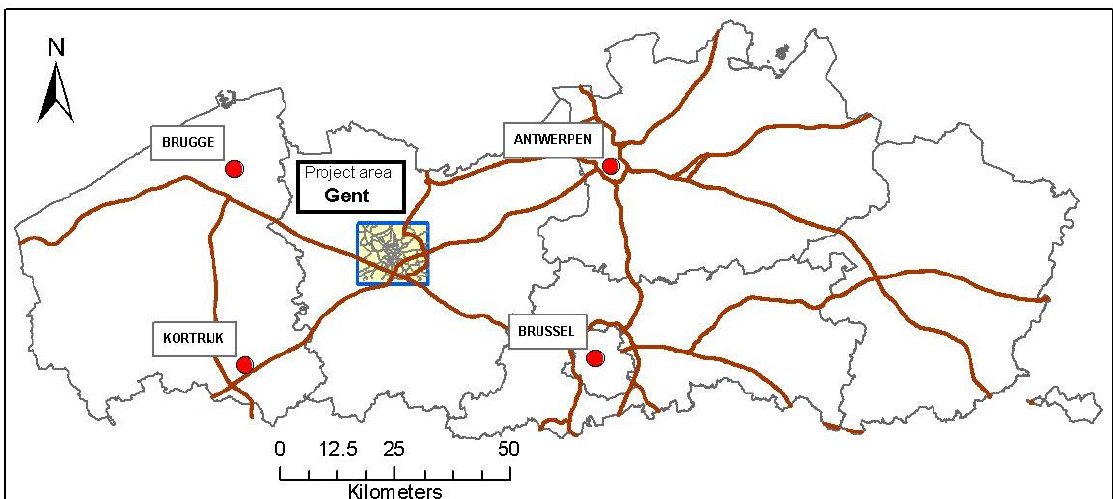
Figure 1. Regional positioning of the project area (blue) within the Flanders, showing the highways (brown) and the major surrounding cities